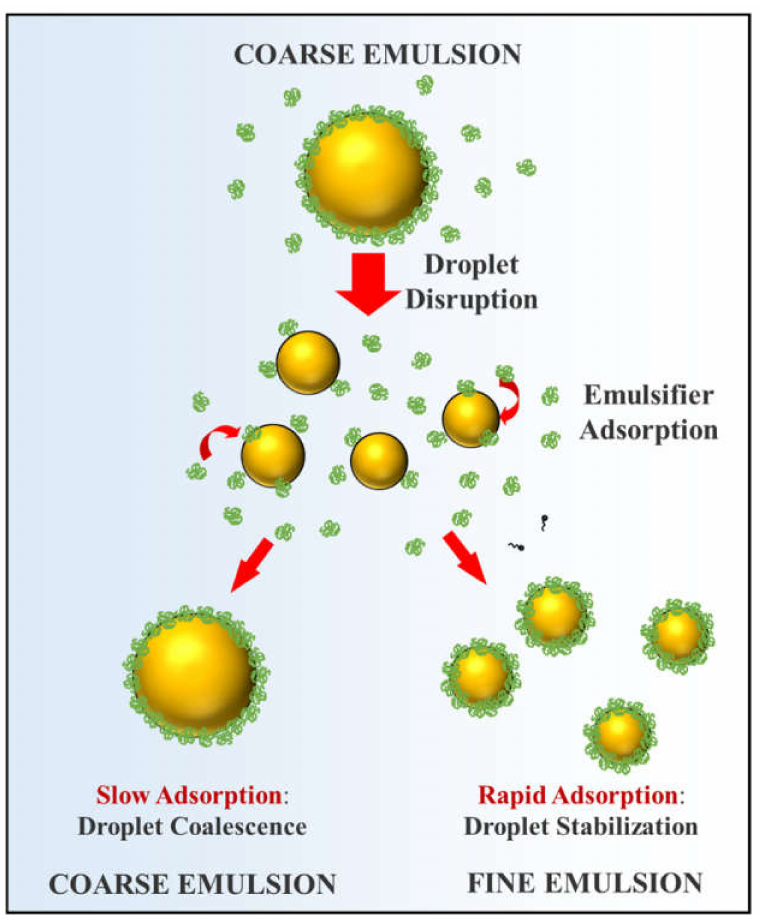
Figure 2. Representation of the major physicochemical processes occurring inside a high-energy homogenizer during emulsion formation: droplet disruption; droplet coalescence; emulsifier adsorp- tion; and droplet stabilization. Small droplets tend to be formed when the emulsifier adsorbs more rapidly than droplet collisions